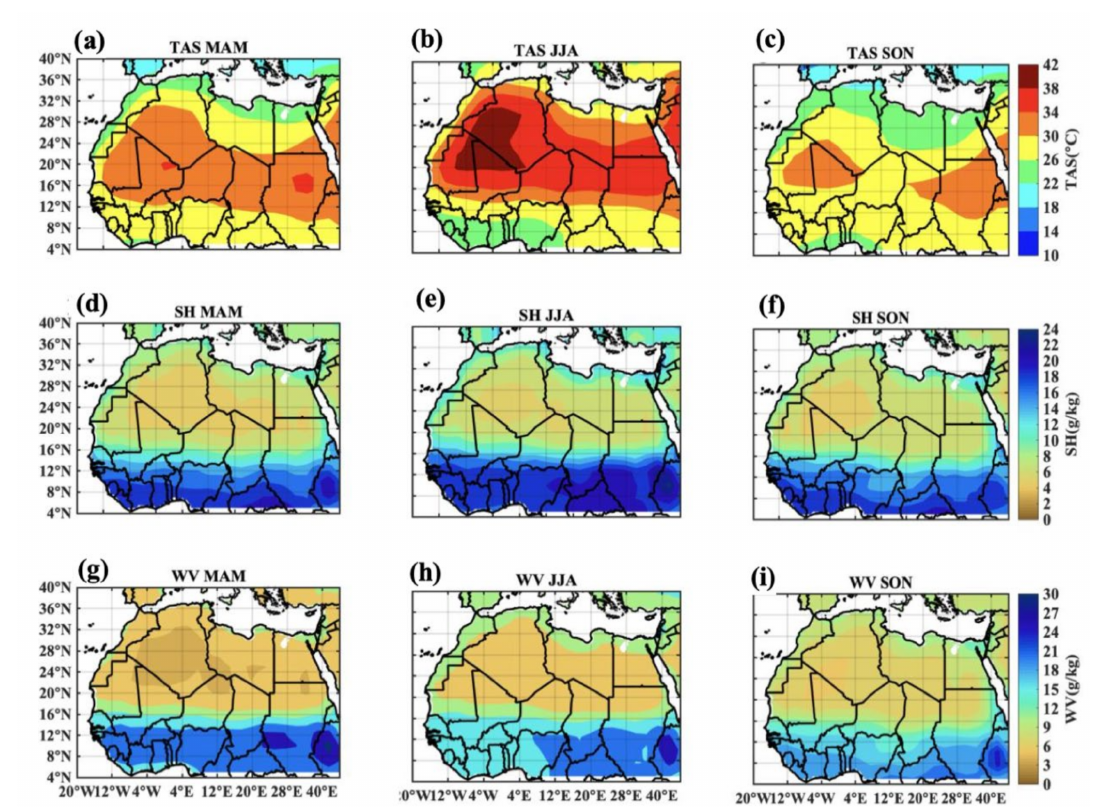
Figure 5. Seasonal spatial patterns of climate parameters over the North and West African countries (20 ◦ W–40 ◦ E; 4 ◦ –40 ◦ N). ( a ) surface air temperature in MAM, ( b ) in JJA, and ( c ) in SON; ( d ) specific humidity in MAM, ( e ) in JJA, and ( f ) in SON; ( g ) water vapor in MAM, ( h ) in JJA, and ( i ) in